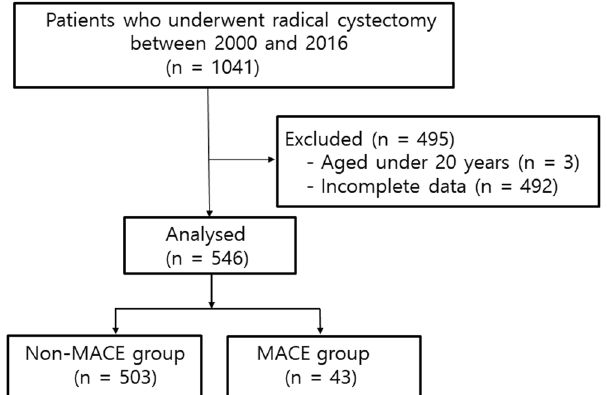
Figure 1. Study flow diagram. MACE = major adverse cardiac